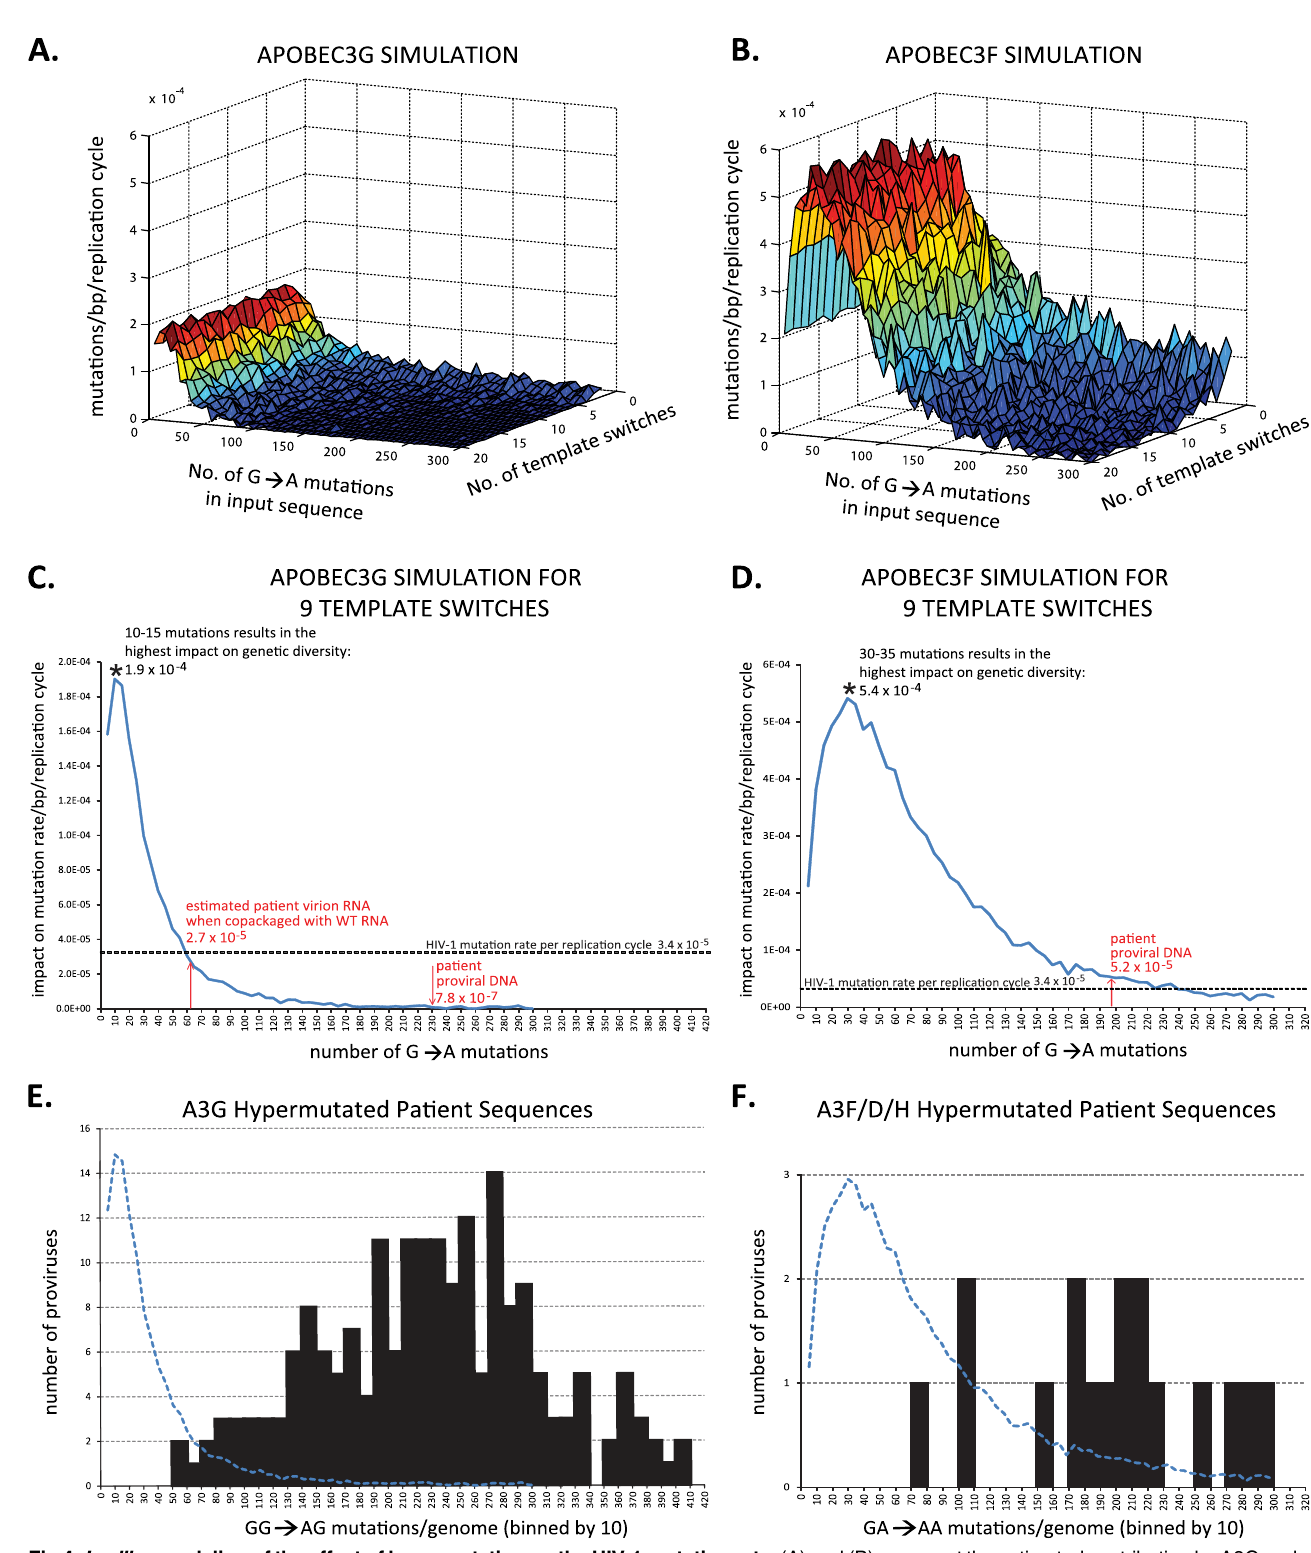
Fig 4. In silico modeling of the effect of hypermutation on the HIV-1 mutation rate. (A) and (B) represent the estimated contribution by A3G and A3F to the HIV-1 mutation rate, respectively. The number of G-to-A changes and the number of template switches were varied. One thousand simulations of a heterozygous virion containing a wild-type genome and a hypermutated genome undergoing one cycle of replication were scored per